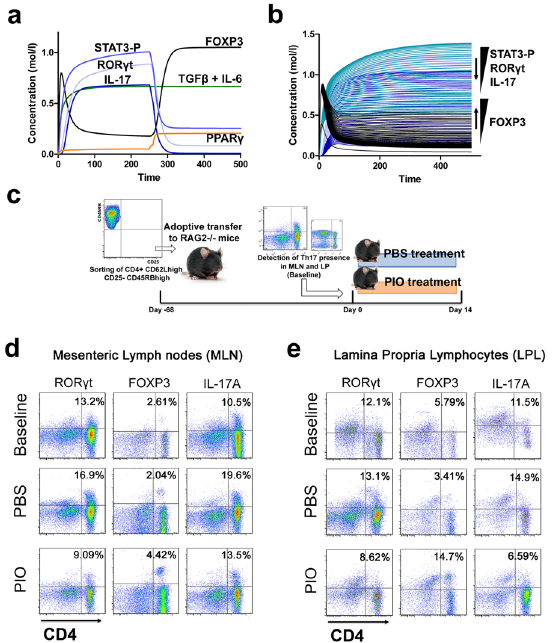
Figure 5. Validation of the modeling prediction regarding the role of peroxisome proliferator-activated receptor (PPAR) c in regulating the plasticity between T helper (Th) 17 and induced regulatory T cells (iTreg). (A) Computer simulation illustrating a down-modulation of IL-17, STAT3, ROR c t and upregulation of FOXP3 in a differentiated Th17 cell following PPAR c activation. (B) Combination of time-course and PPAR c concentration scan to assess changes of IL- 17, STAT3, ROR c t and FOXP3 over time. (C) Experimental design for the validation of the model prediction. (D–E) Accumulation of iTreg and Th17 cells in the mesenteric lymph nodes (MLN) and colonic lamina propria (LP) of recipient mice.